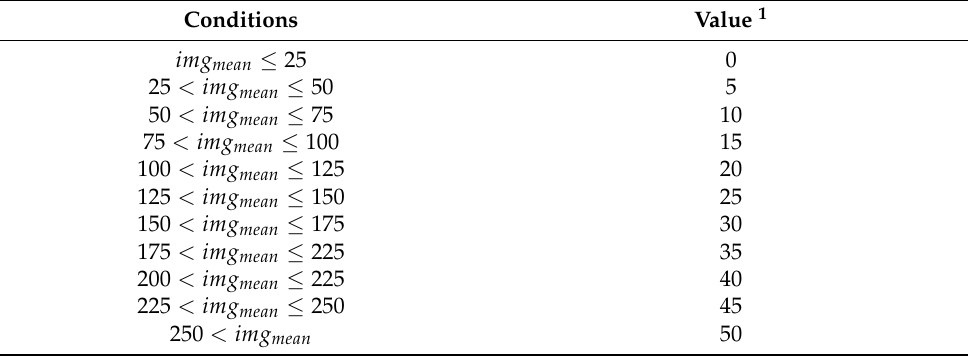
Table 2. The constant C to correct ρ from ρ